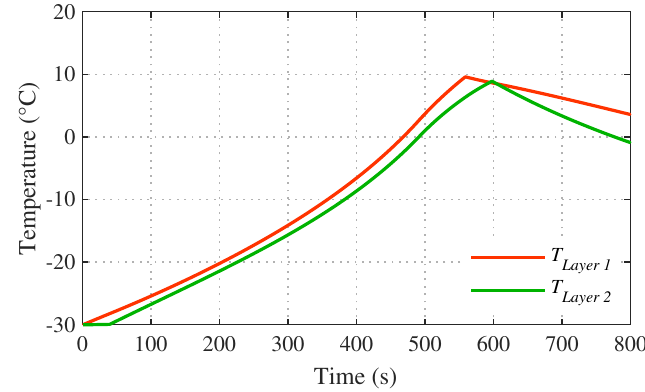
Figure 12. Temperature responses of two layers in the battery pack at T amb = − 30 ◦